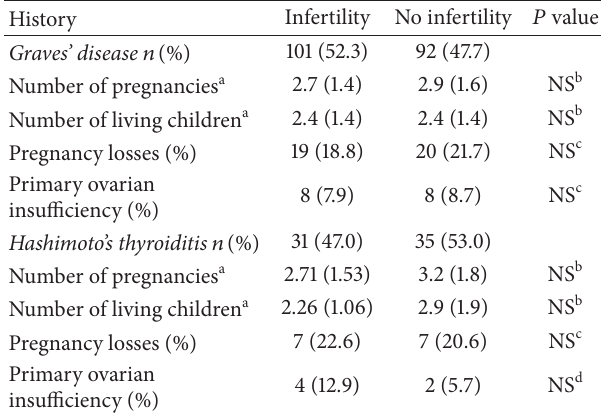
Table 1: Characteristics of the women with GD and HT who reported or did not report a period of infertility.